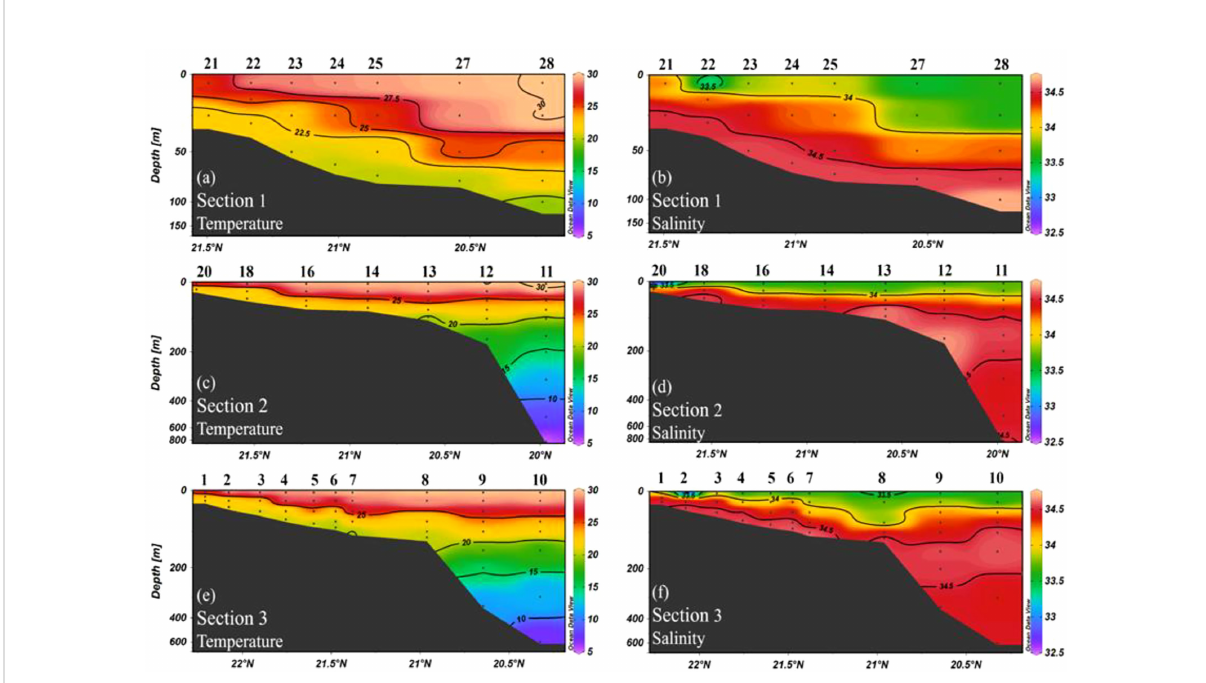
FIGURE 2 Vertical distribution of temperature and salinity in three sections as de fi ned in Figure 1. Note that the depth scale is not linear where the upper 400 m was